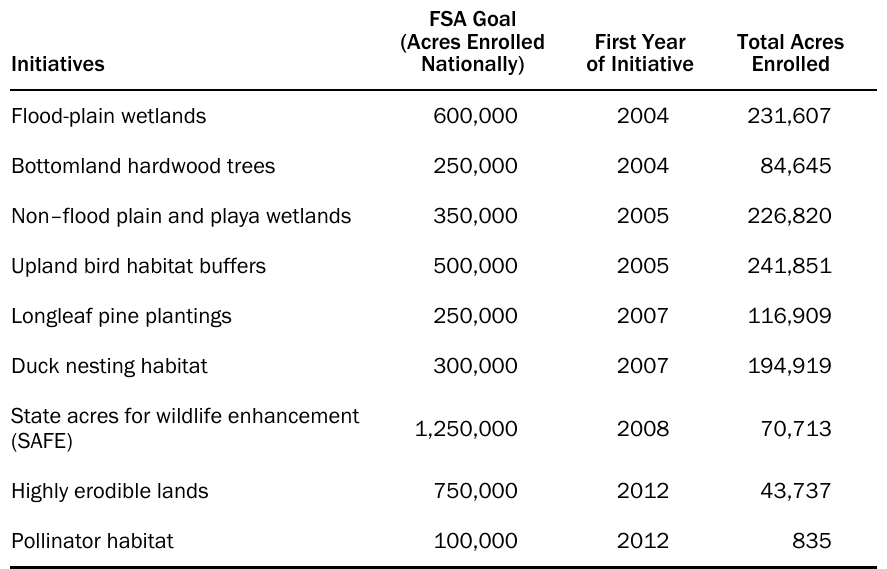
Table 1. FSA CRP Initiatives and Acreage under